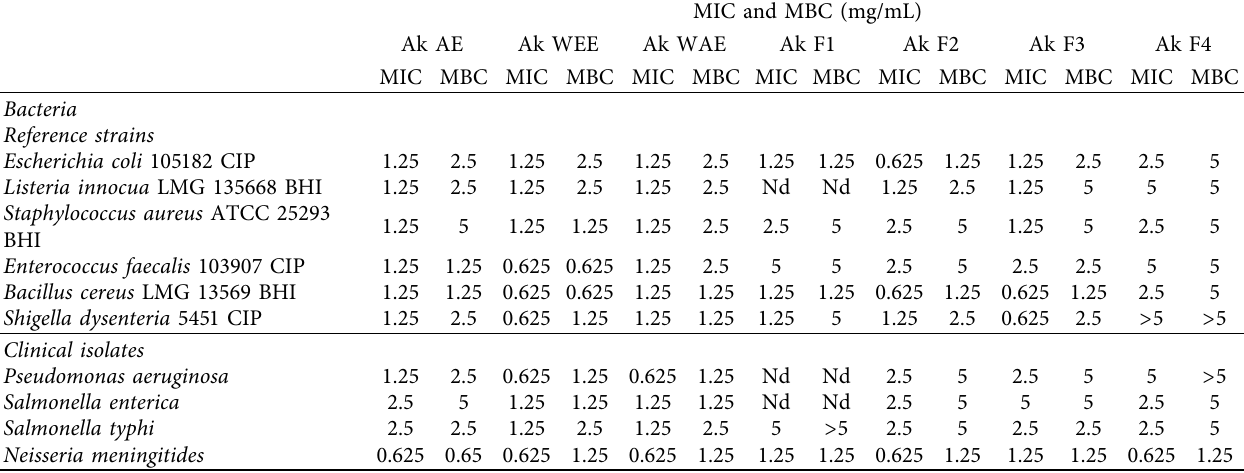
Table 3: Minimum inhibitory concentration (MIC) and minimum bactericidal concentration (MBC) or minimum fungicidal concentration (MFC) of crude extracts and fraction of Antrocaryon klaineanum .